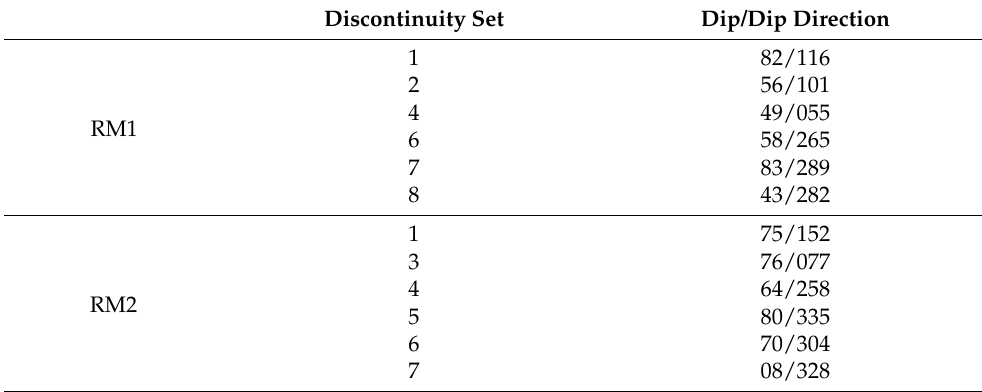
Table 3. List of discontinuity sets extracted according to the biased ISRM